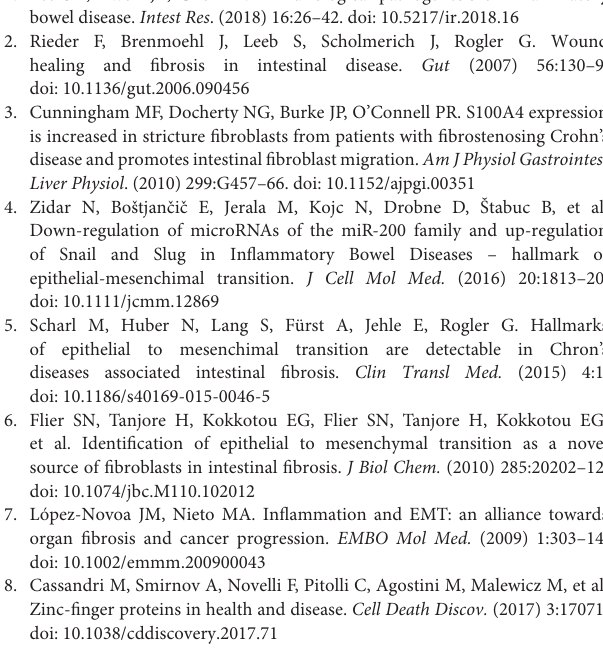
Supplementary Figure 1 | Assessment of DSS induced-colitis in mice. Analyzed parameters were analyzed: (A) weight loss; (B) colon length; (C) total clinical score (stool consistency, presence of blood in stool, and general appearance); (D, E) histology and histological score (10 × magnification in the image); (F) cytokine mRNA expression (IL-1beta, IL-6). Data are presented as mean ± S.D. of 6 animals for each group. UN, untreated animals; DSS, dextran sodium sulfate. Supplementary Figure 2 | Whole gels of in vivo experiments. Supplementary Figure 3 | Whole gels of controls and CD patients. Supplementary Figure 4 | Whole gels of UC